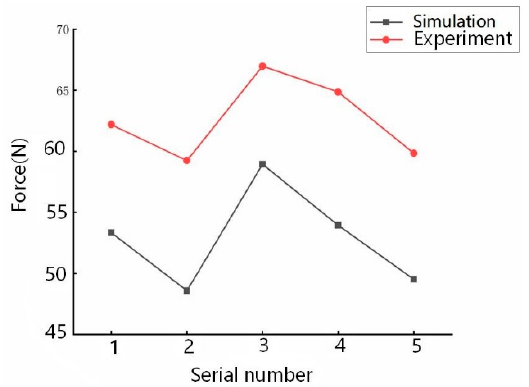
Figure 6. Contrast